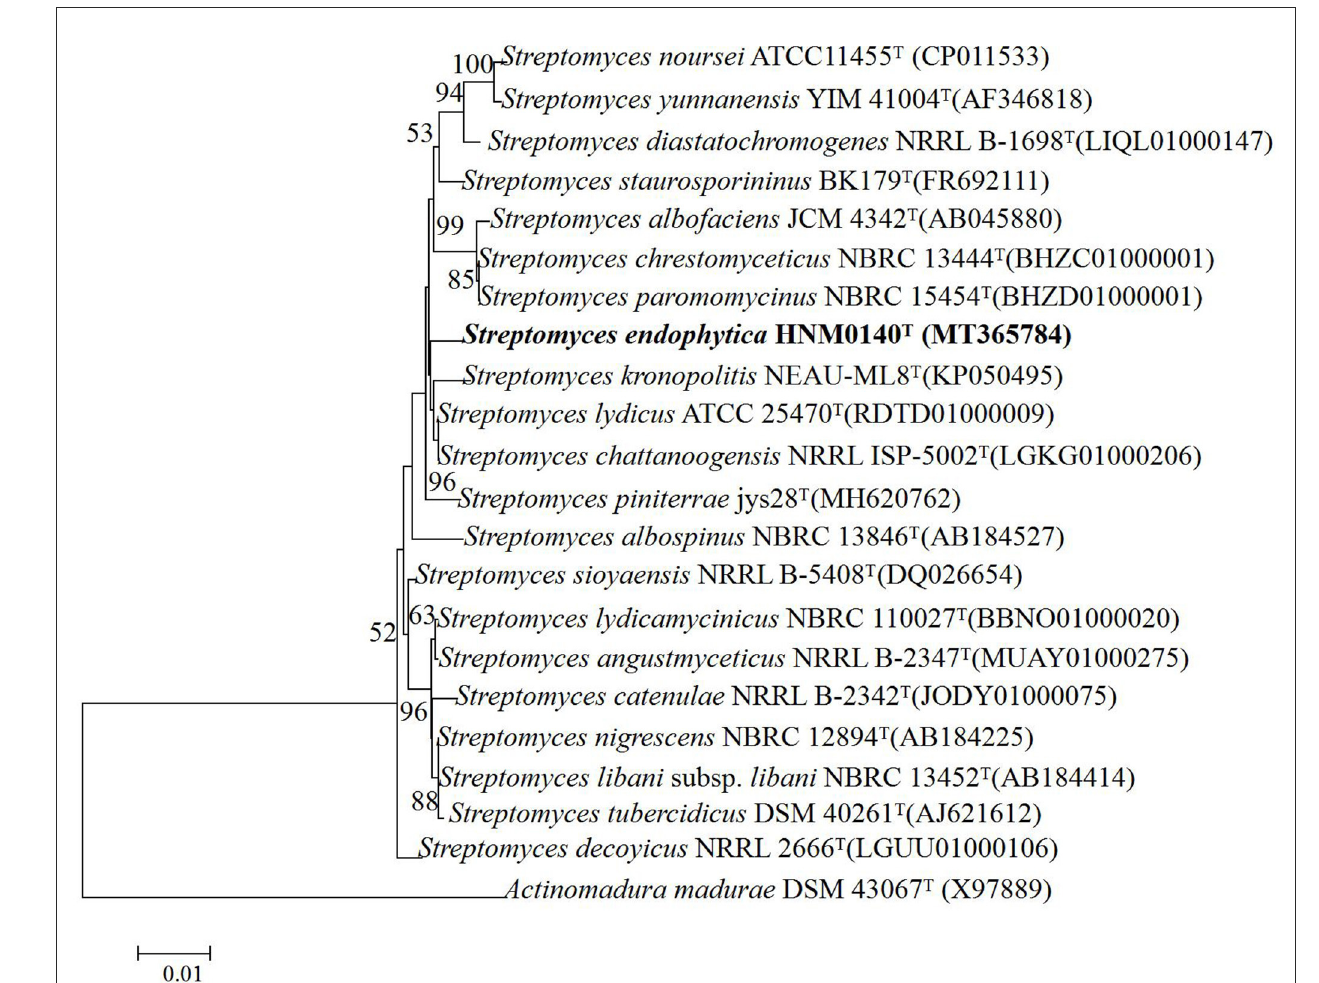
FIGURE4 Neighbor-joining phylogenetic tree of strain HNM0140 T based on 16S rRNA gene sequences. The bootstrap values (%) presented at the branches were calculated from 1,000 replications, only values > 50% are given. Scale bar indicates 0.01 substitutions per nucleotide position.